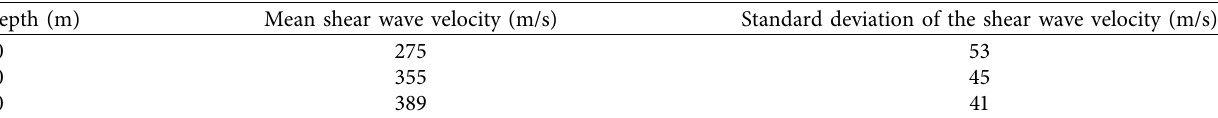
Table 3: Mean and standard deviation of the shear wave velocities at depths of 10m, 30 m, and 50m. Depth